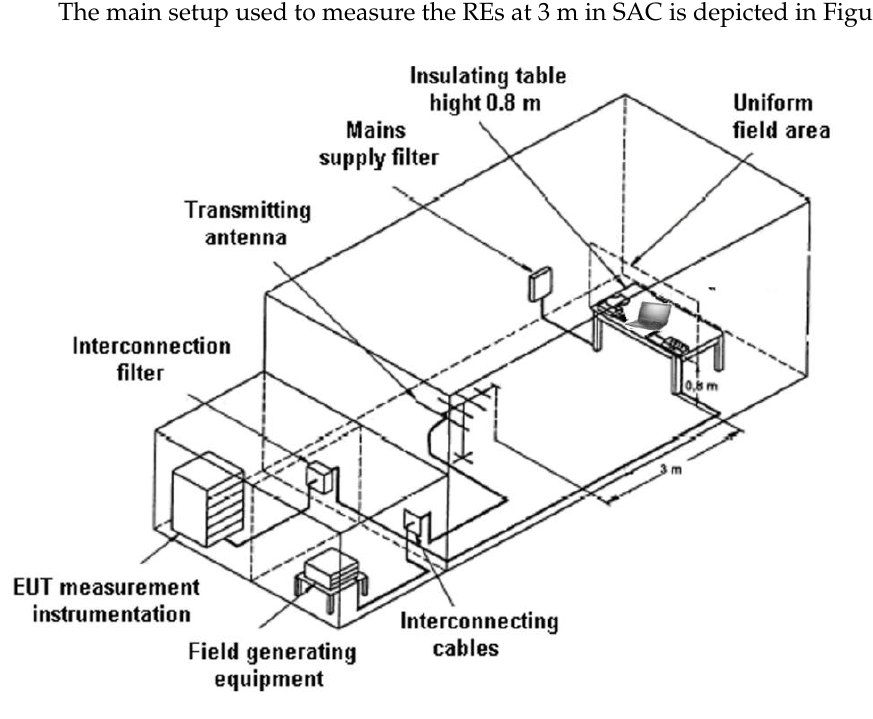
Figure 14. The principle of a setup used to measure radiated emissions at 3 m in Semi-Anechoic Chamber